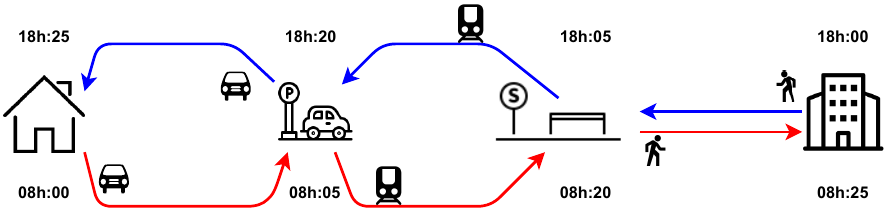
Figure 3. Inter-modal travel combining personal car and public transport, where car_pt mode for the outward journey is represented in red and pt_car mode for the return journey is in